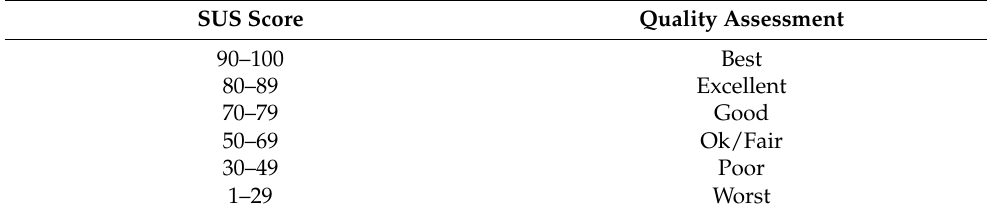
Table 10. Quality assessment